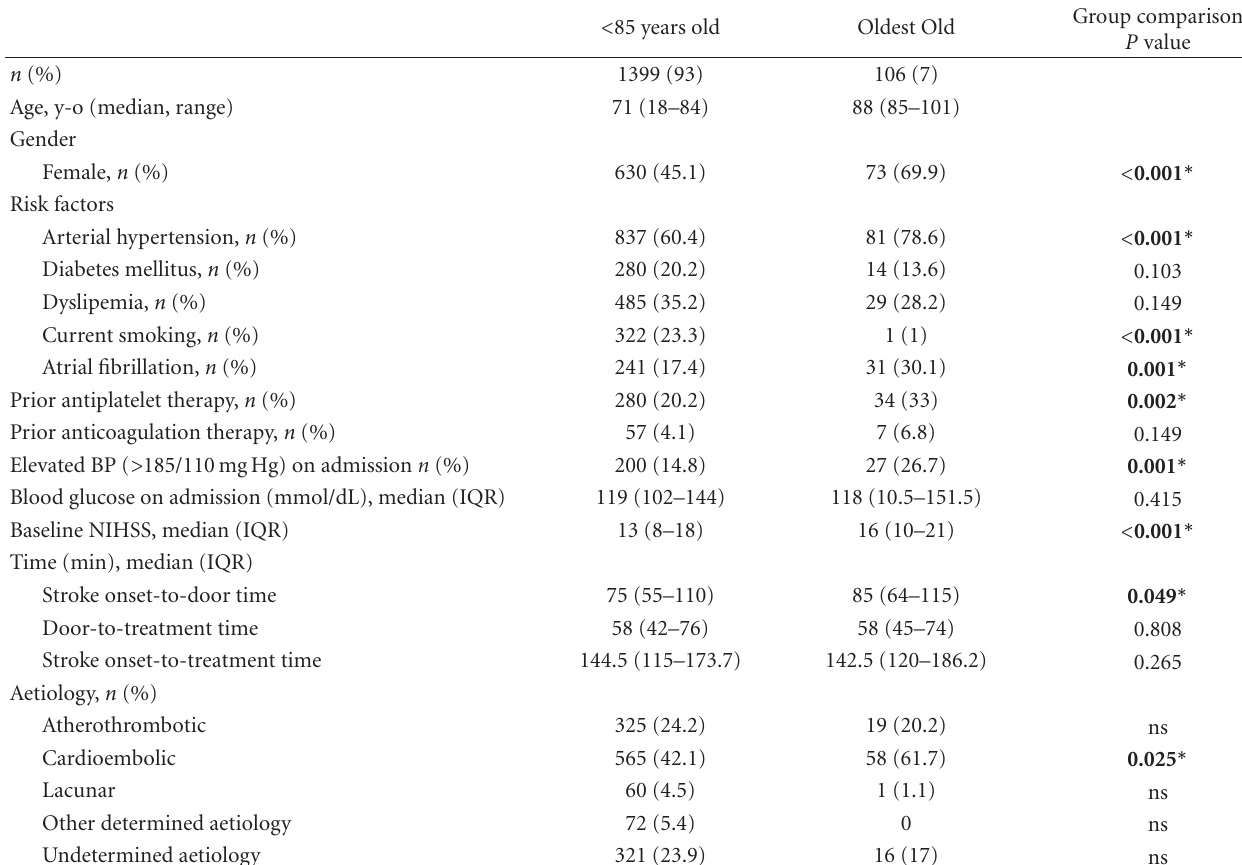
Table 1: Baseline characteristics and aetiology.